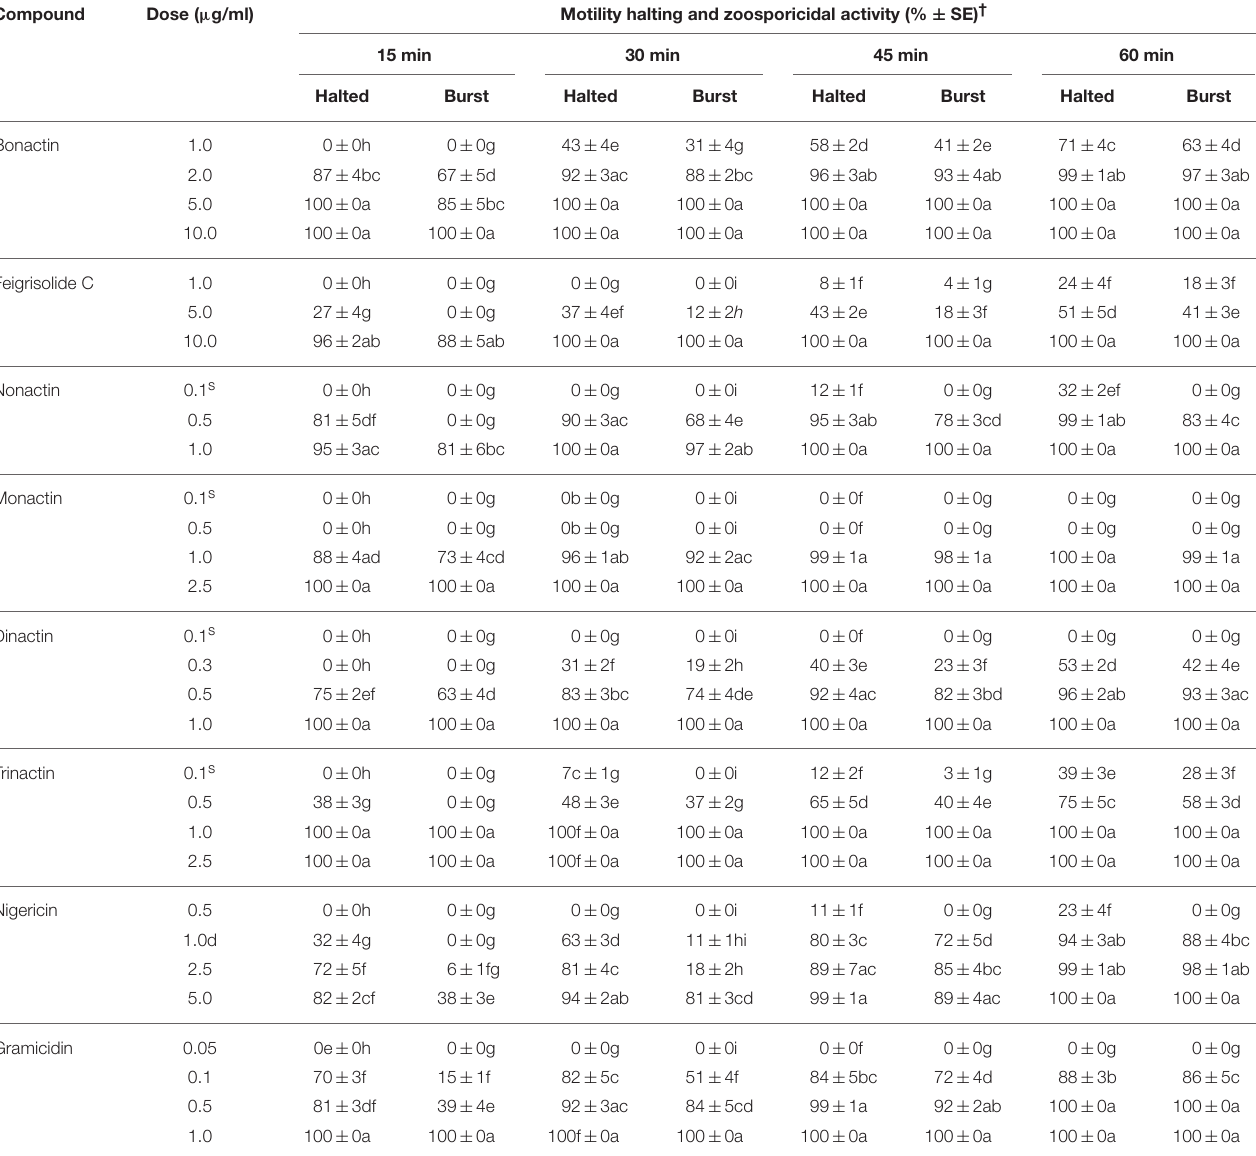
TABLE 3 | Motility inhibitory and zoosporicidal activity of bonactin, feigrisolide C, macrotetrolide antibiotics (nonactin, monactin, dinactin and trinactin), nigericin and gramicidin against the grapevine downy mildew pathogen Plasmopara viticola . Compound Dose ( µ g/ml)